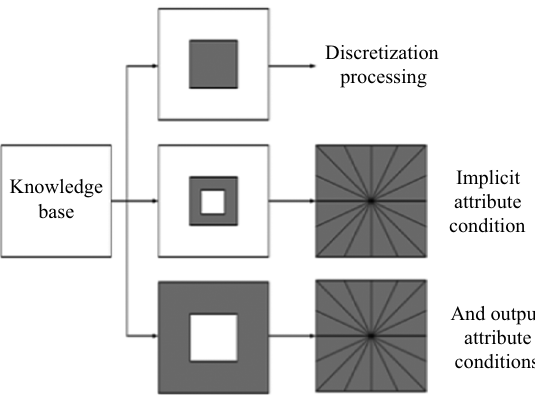
Figure 1: The model of music teaching and ideological and political integration in colleges and